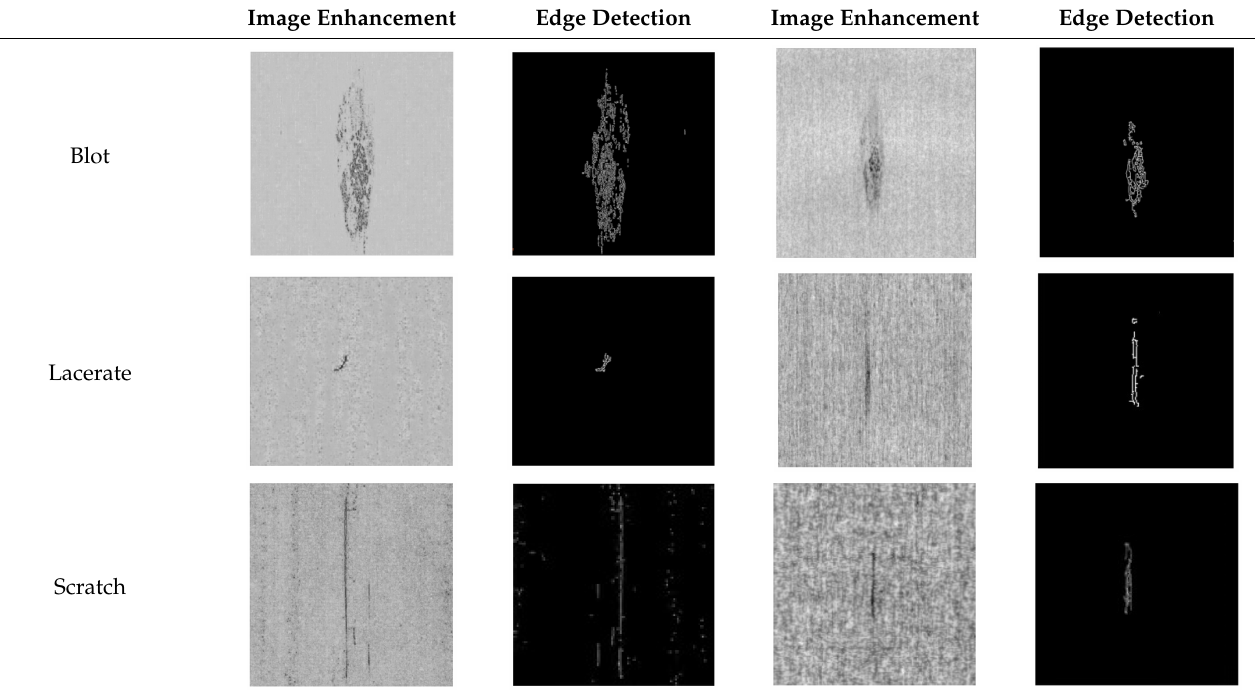
Table 5. Aluminum strip surface defect edge extraction.